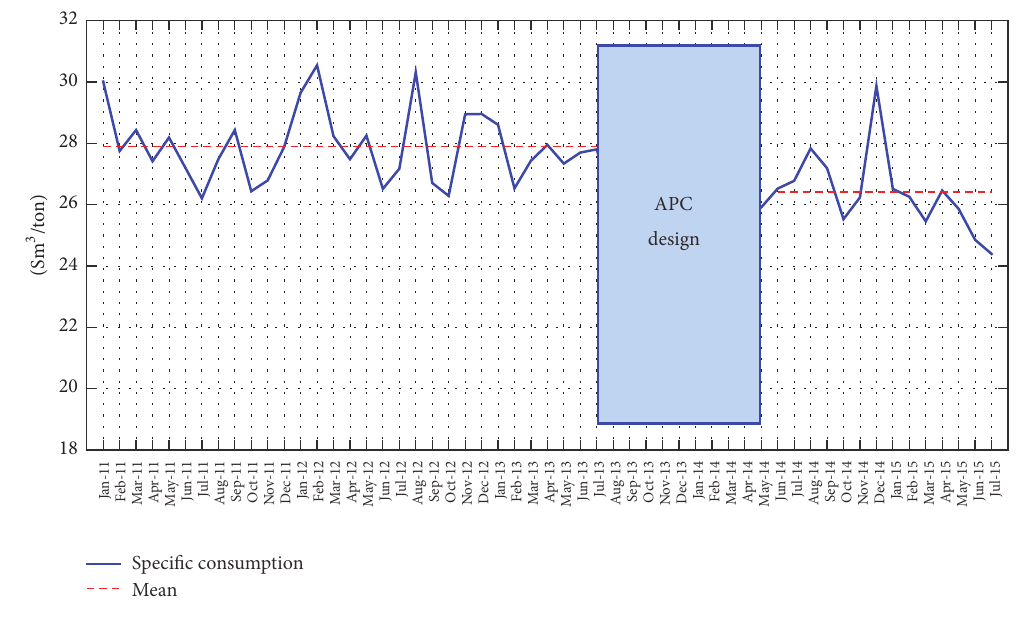
Figure 16: Fuel specific consumption trends and related expected values without and with the designed APC